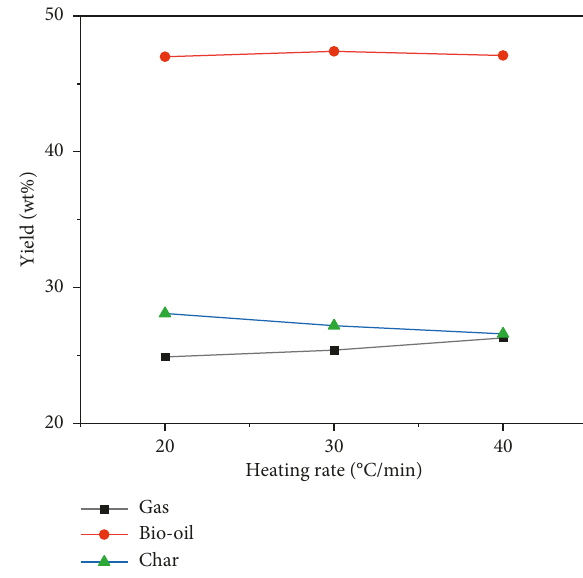
Figure 4: Effect of heating rate on product distribution. Figure 3: Effect of sweep gas flow rate on product distribution. Table 2: Physical characteristics of the bio-oil.